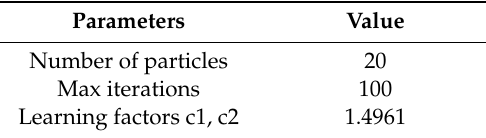
Table 3. PSO parameter settings.